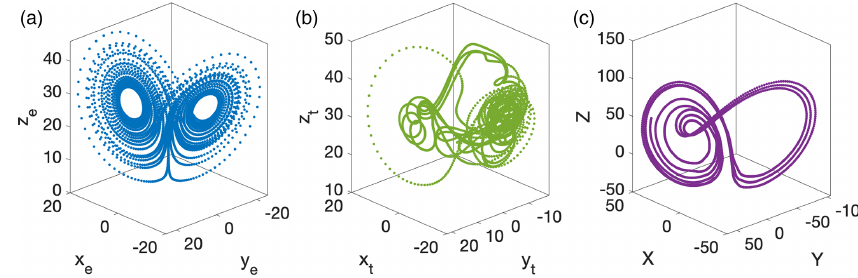
Figure 2. Trajectories along attractors of the extratropical (a) , tropical (b) , and ocean (c) subsystems of Eq.